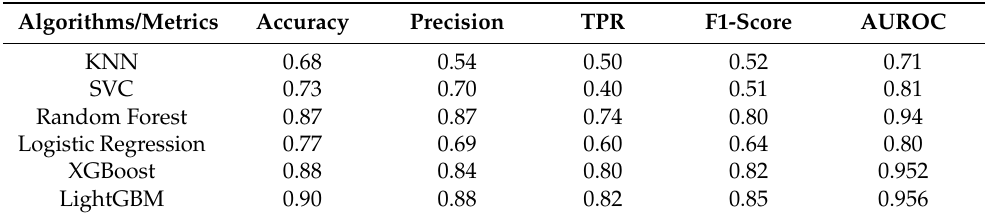
Figure 14. The receiver operating characteristic curve (ROC) for exams includes VRL-based and static questions. Table 6. A detailed description of the used machine learning algorithms and the metrics used to test these models for exams, including both VRL-based and static questions.